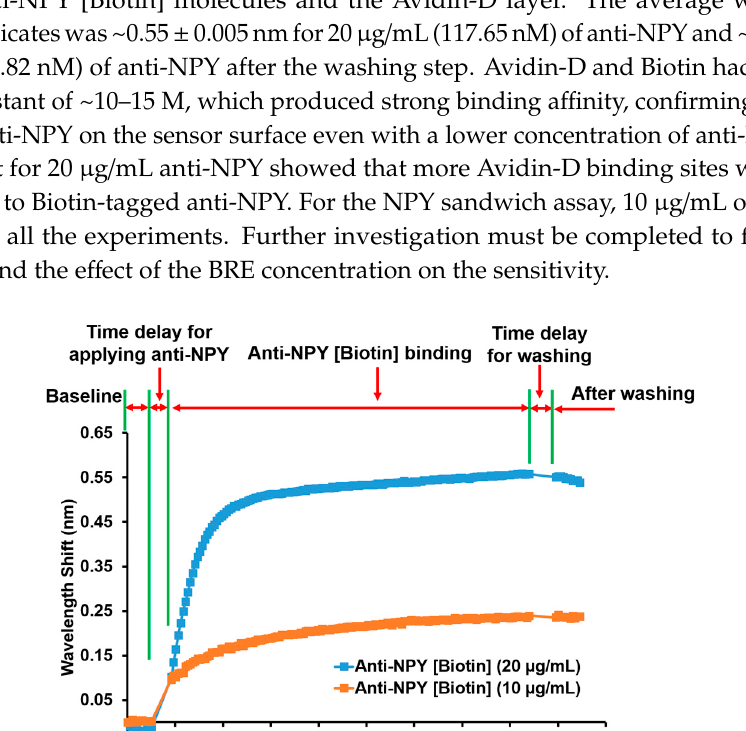
Figure 3. Wavelength shift and process steps as a function of time for 50, 100, 200, and 250 μ g/mL Avidin-D concentrations. The final wavelength shifts are approx. 0.67, 0.86, 1.03, and 0.92 nm for 50, 100, 200, and 250 μ g/mL Avidin-D, respectively.